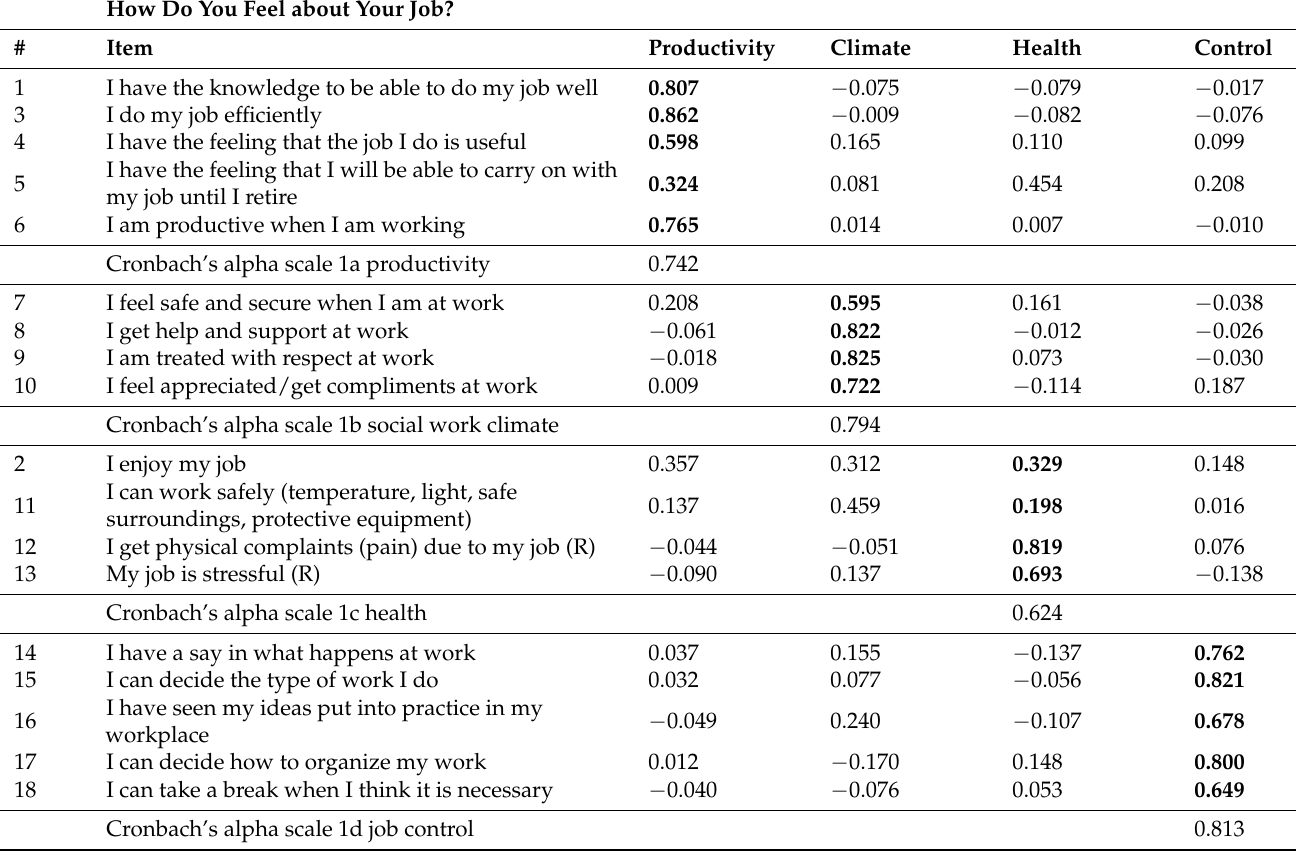
Table 2. PCA MAISE-Easy Area 1—Level of SE (productivity, social work climate, health, job control), oblimin rotation.